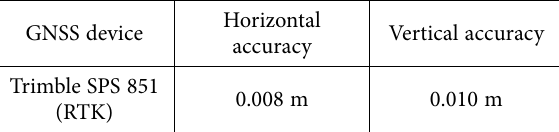
Table 3. An average achieved accuracy of GNSS devices GNSS device